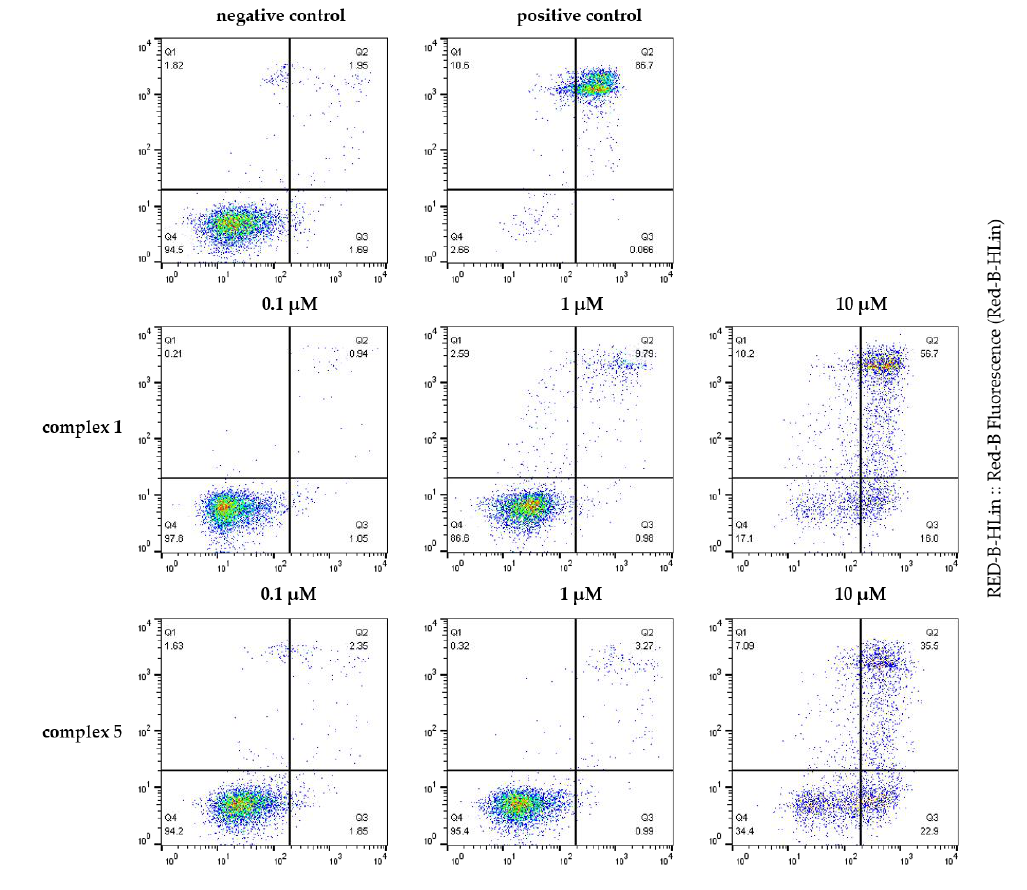
Figure 9. To distinguish the viable (Q4), early apoptotic (Q3), late apoptotic (Q2) and necrotic (Q1) cell counts, SW480 cells treated with complexes 1 and 5 at three different concentrations were subject to annexin V-FITC (x-axis) and PI (y-axis) staining, detected by flow cytometry. As a positive control, 1-P was used [42] . The dot plots represent a representative experiment out of at least three.